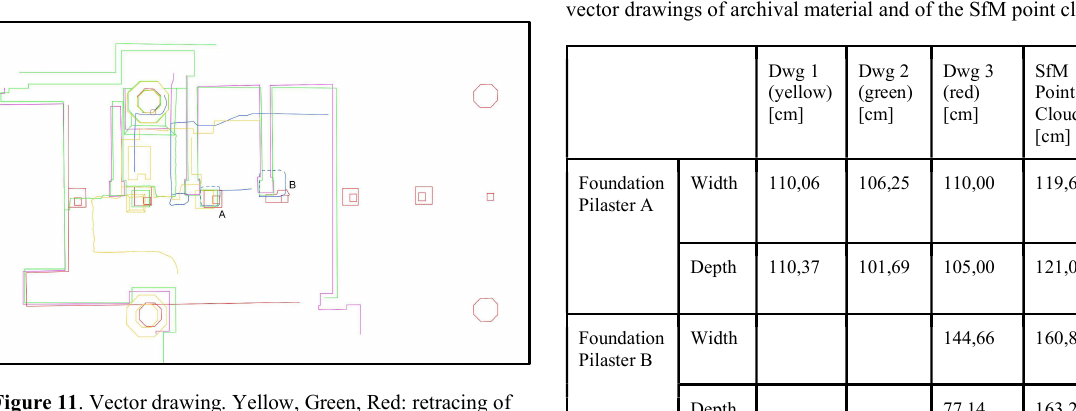
Figure 11 . Vector drawing. Yellow, Green, Red: retracing of historical drawings by the Soprintendenza. Purple and blue: same as Figure 10.